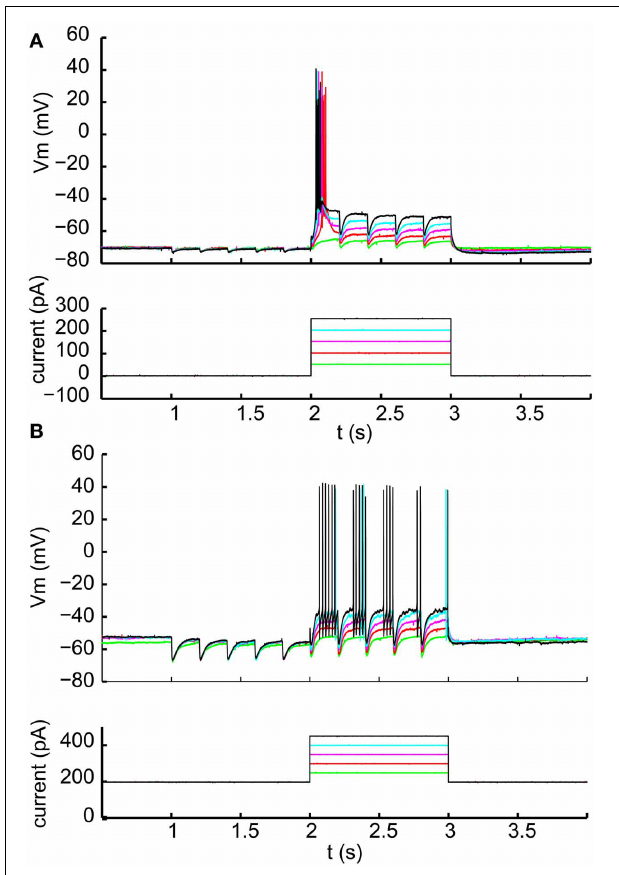
FIGURE 4 | Failure of nigral single IPSPs triggered by 5ms light pulses to elicit LTS bursts at any membrane potential. (A) Trains of IPSPs at 5Hz at rest and during varying levels of depolarizing current injection as shown below the voltage traces. (B) Trains of IPSPs at 5Hz during a depolarized baseline and subsequent additional inward current